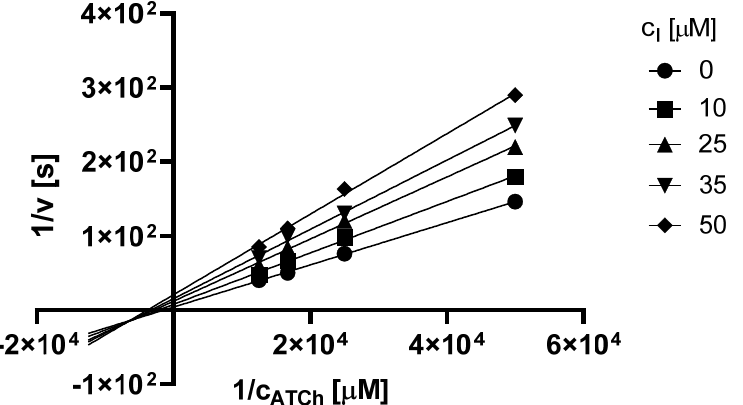
Figure 4. Lineweaver–Burk plot for 3t and AChE inhibition (ATCh = acetylthiocholine).